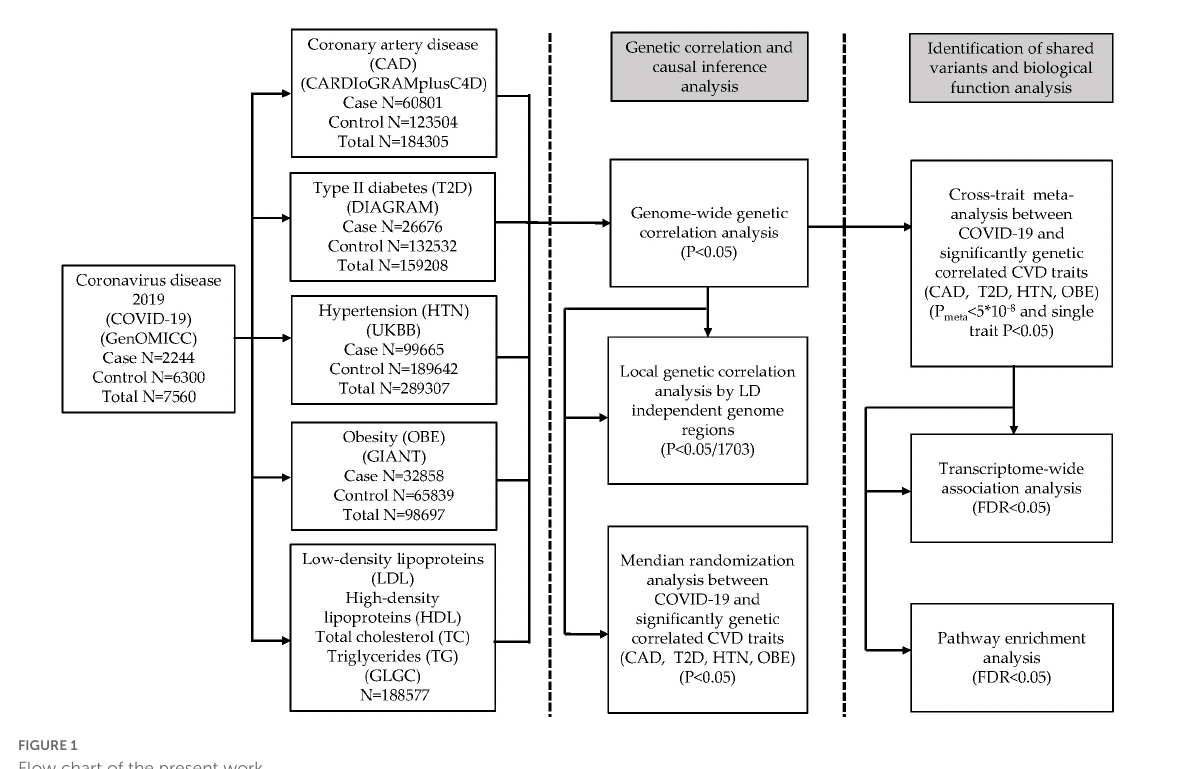
FIGURE1 Flow chart of the present